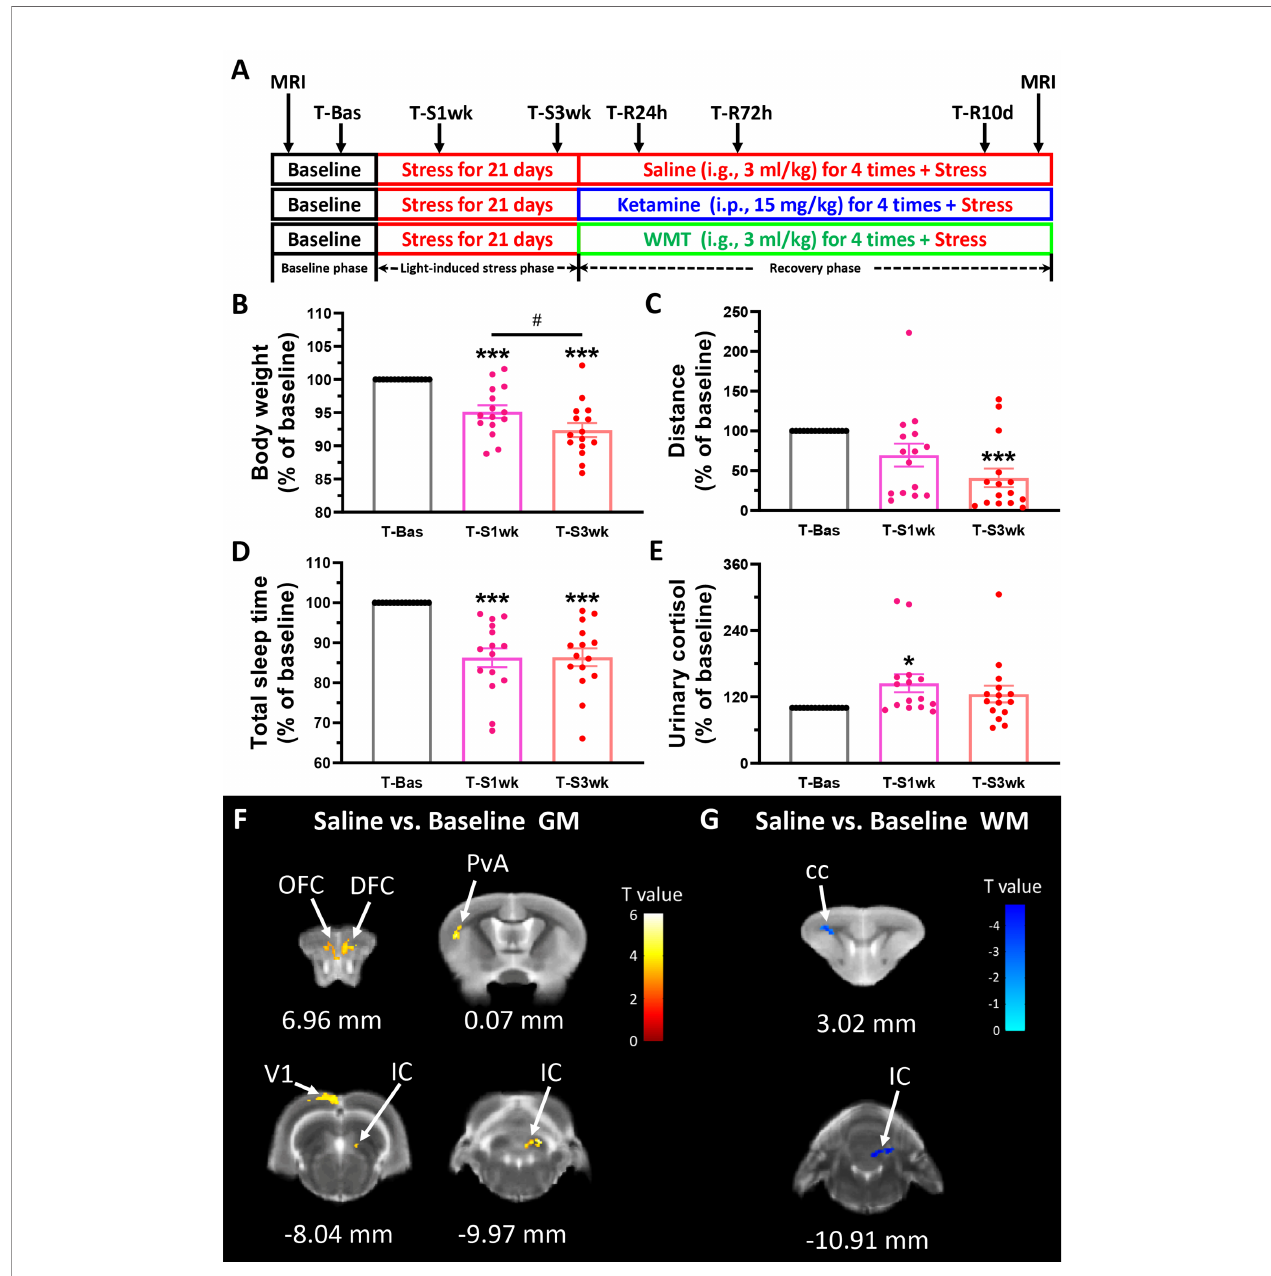
FIGURE 1 | Physiological responses and brain structure changes in the tree shrew after staying up late for 21 days. (A) Experimental design. Basic data was collected in the baseline phase (T-Bas), including MRI scanning, weight, urinary and stool collection, locomotor activity and total sleep time measurements. In the light-induced stress phase, the facility light cycle was changed (light on at 8:00, light off at 24:00). All of the above indicators, except MRI scanning, were tested extended light exposure for one week (T-S1wk) and three weeks (T-S3wk). Ketamine (15 mg/kg), WMT (3 ml/kg) or vehicle (0.9% saline, 3 ml/kg) were administrated at the beginning of the recovery phase for a total of four times. We tested all physiological and biochemical indicators in the ketamine, WMT or vehicle (saline) conditions 24 h (T-R24h), 72 h (T-R72h) and 10 days (T-R10d) after administration. At the end of the experiment, MRI scans were performed on the same animals. (B – E) All of the physiological and biochemical indicators after light-induced stress for 1 week (T-S1wk) and 3 weeks (T-S3wk) were normalized with their values in the baseline phase (T-Bas) to explore the effects of extended and prolonged light exposure. Body weight ( B , N = 15), distance travelled in an open fi eld box ( C , N = 15) and total sleep time ( D , N = 15) were all decreased, and morning urinary cortisol ( E , N = 15, [F(42,2) = 3.025, p = 0.059], LSD Post Hoc: T-S1wk compared with T-Bas, p = 0.018) was increased after staying up late for 21 days. (F) The GM density signals from OFC (orbital frontal cortex), DFC (dorsal frontal cortex), PvA (parietal ventral area), V1 (primary visual cortex) and IC (inferior colliculus) were all increased (N = 3/group). (G) The WM density signals from cc (corpus callosum) and IC were decreased (N = 3/group). Error bars show the SEM. *means compared with control in baseline phase, *p <0.05, ***p <0.001. # means compared between each other in stress phase, #p